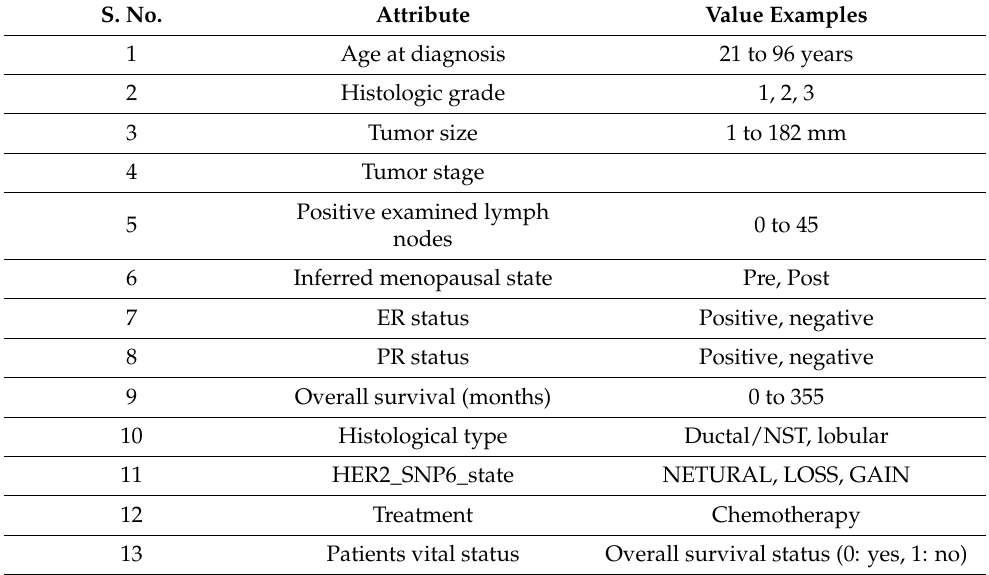
Table 8. CLNICAL dataset